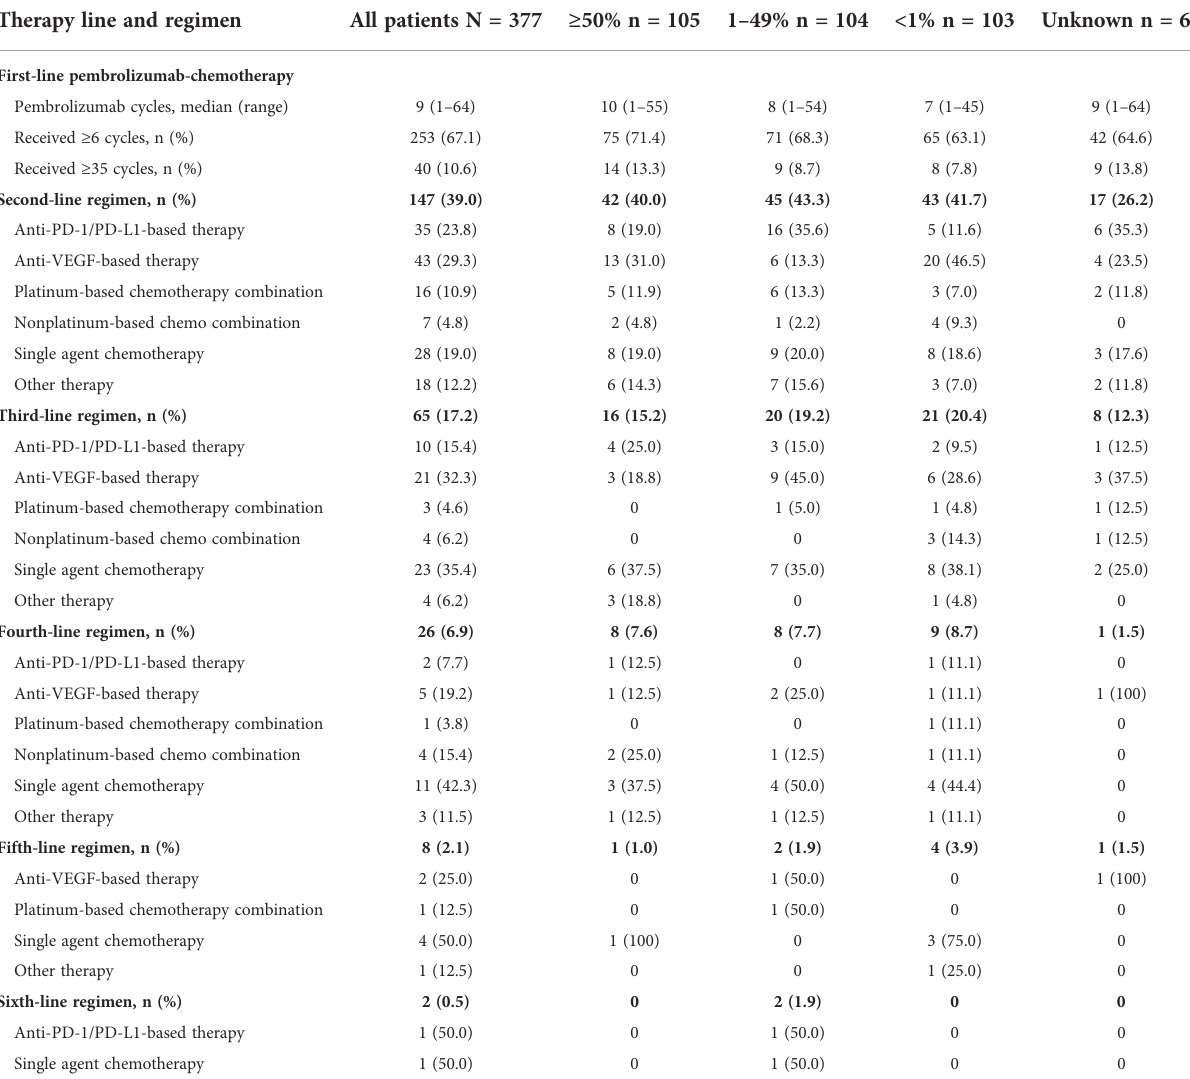
TABLE 2 Systemic anticancer therapy lines and